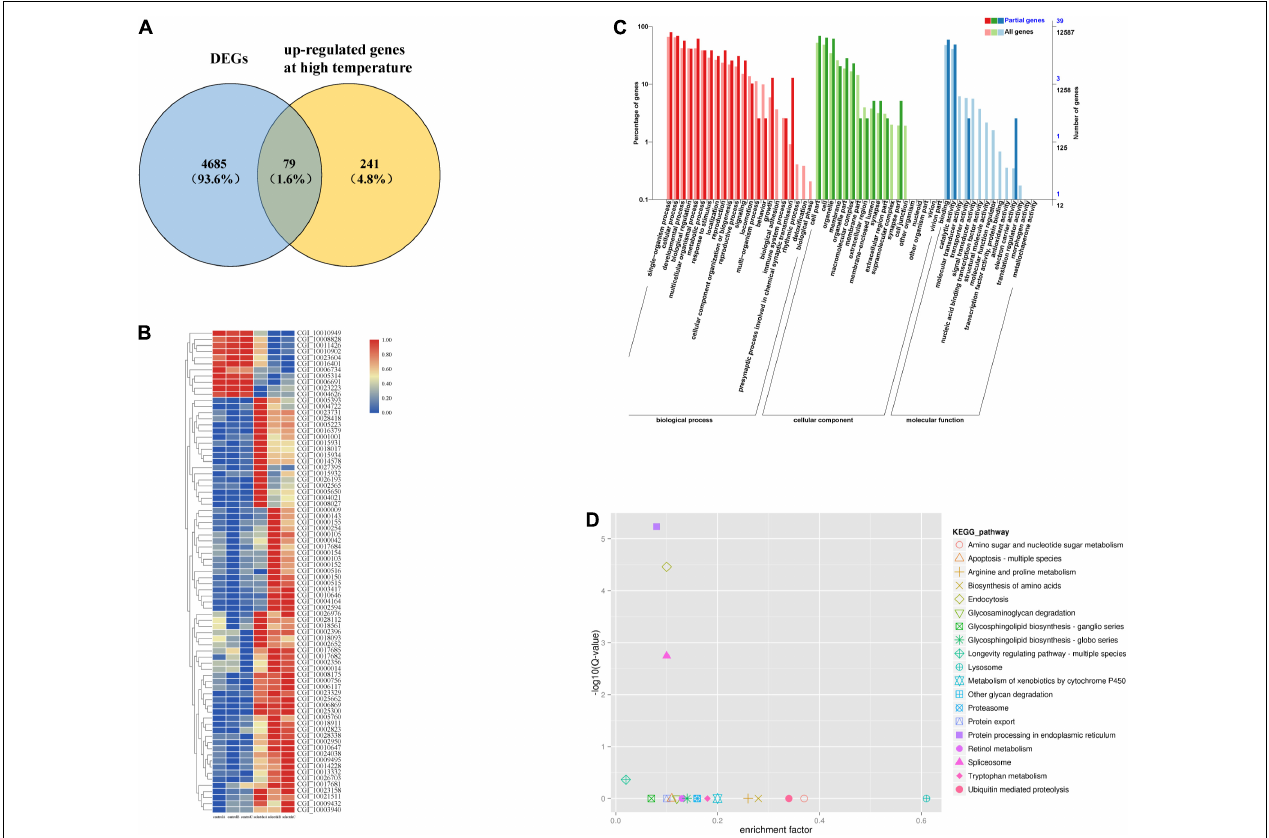
FIGURE 1 | Among the high temperature response gens and DEGs, 79 genes were responsive to heat shock (A) . Hierarchical cluster analysis of 79 genes (B) . GO enrichment analysis of 79 genes (C) . KEGG enrichment analysis of 79 genes (D) .